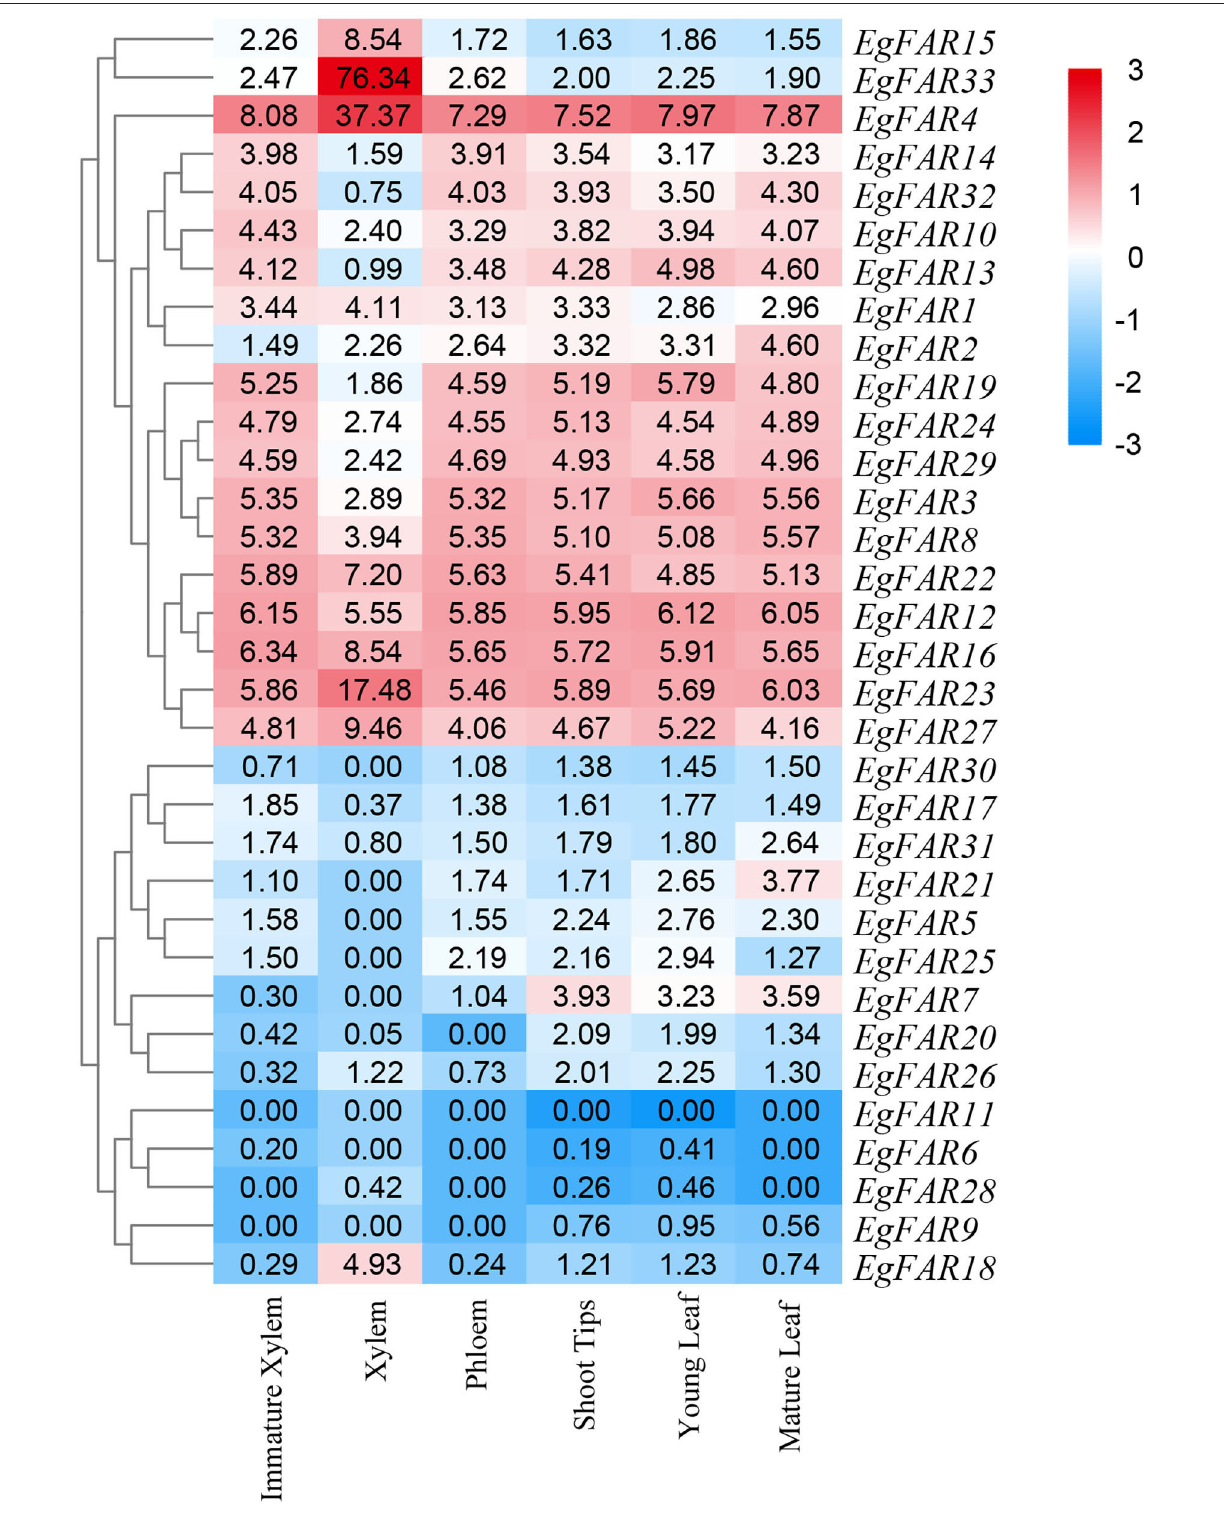
Frontiers in Plant Science |